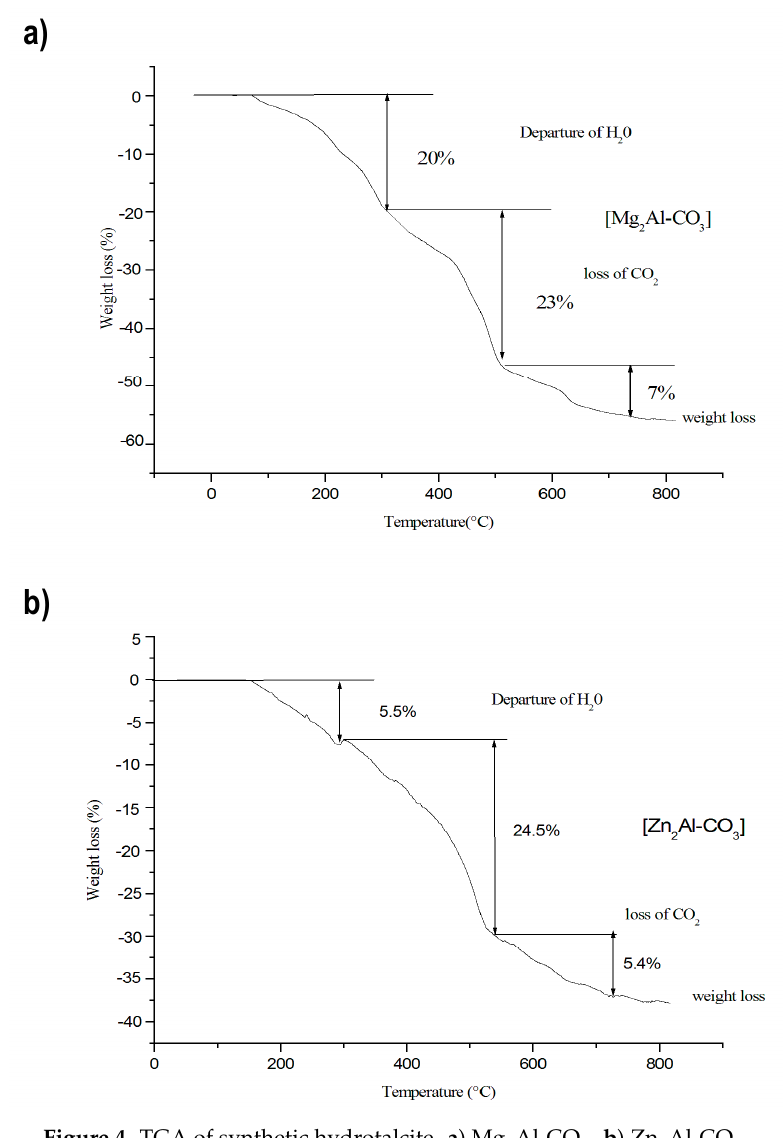
Figure 4. TGA of synthetic hydrotalcite. a ) Mg 2 Al-CO 3 . b ) Zn 2 Al-CO 3 .